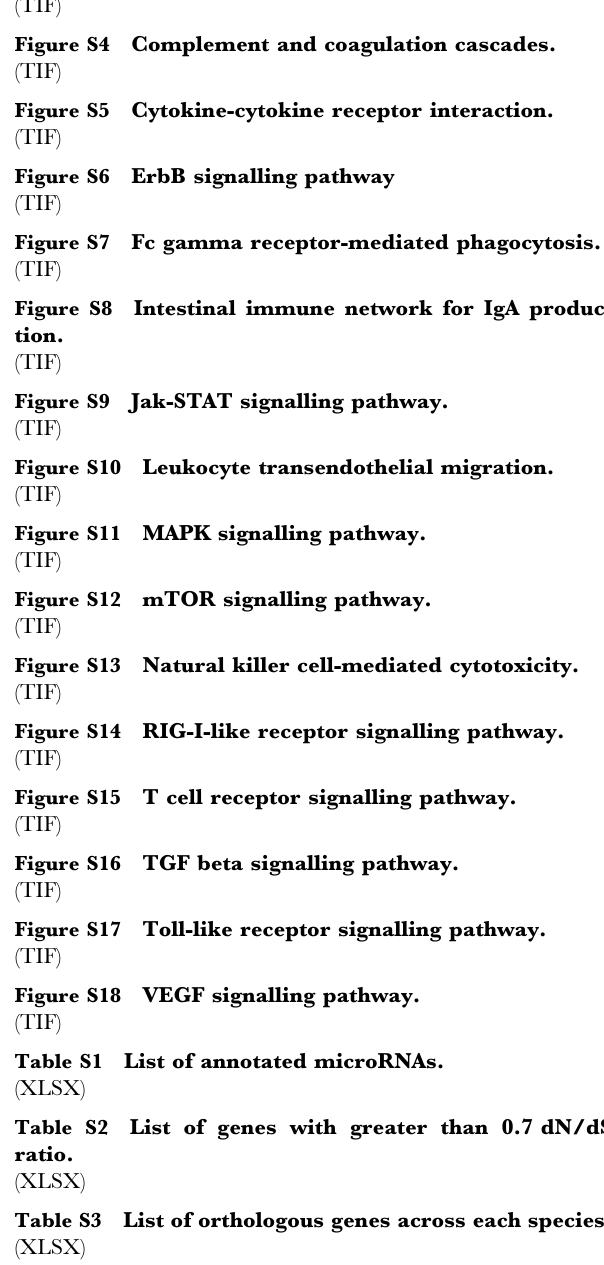
Figure S1 B cell receptor signalling pathway. (TIF) Figure S2 Cell adhesion molecules. (TIF) Figure S3 Chemokine signalling pathway. (TIF) Figure S4 Complement and coagulation cascades. (TIF) Figure S5 Cytokine-cytokine receptor interaction. (TIF) Figure S6 ErbB signalling pathway (TIF) Figure S7 Fc gamma receptor-mediated phagocytosis. (TIF) Figure S8 Intestinal immune network for IgA produc- tion. (TIF) Figure S9 Jak-STAT signalling pathway. (TIF) Figure S10 Leukocyte transendothelial migration. (TIF) Figure S11 MAPK signalling pathway. (TIF) Figure S12 mTOR signalling pathway. (TIF) Figure S13 Natural killer cell-mediated cytotoxicity. (TIF) Figure S14 RIG-I-like receptor signalling pathway. (TIF) Figure S15 T cell receptor signalling pathway. (TIF) Figure S16 TGF beta signalling pathway. (TIF) Figure S17 Toll-like receptor signalling pathway. (TIF) Figure S18 VEGF signalling pathway. (TIF) Table S1 List of annotated microRNAs. Table S2 List of genes with greater than 0.7 dN/dS ratio. Table S3 List of orthologous genes across each